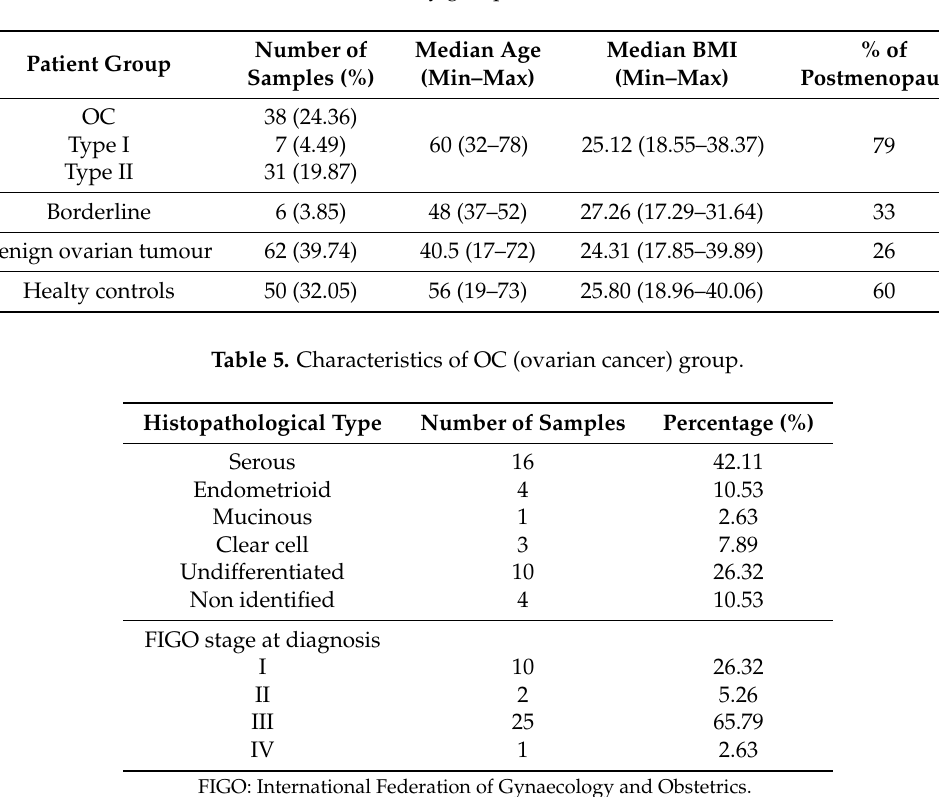
Table 4. Study group characteristics.